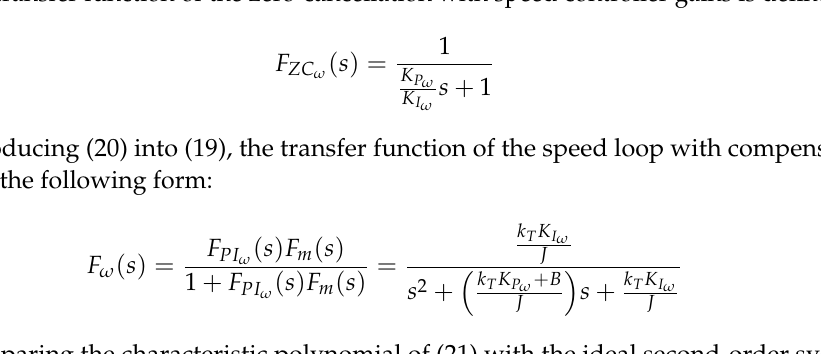
Figure 9. Block diagram of the simplified speed loop with zero ‐ cancellation.